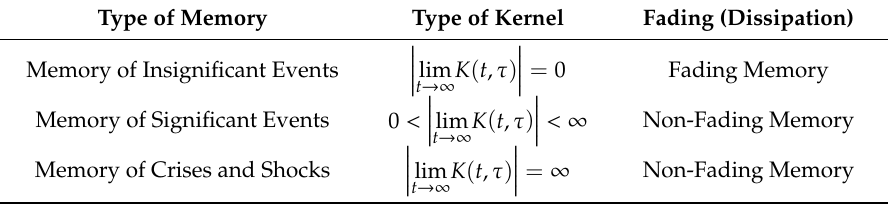
Table 2. Examples of the correspondence between the type of memory and type of operator